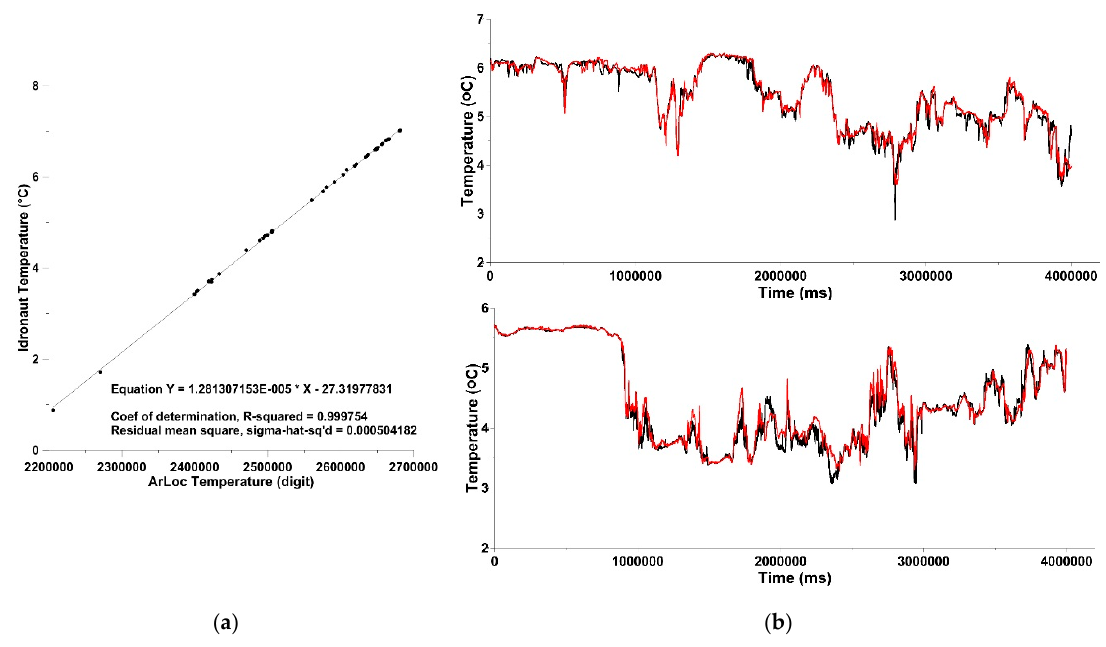
Figure 7. ( a ) Comparison between Idronaut 305 plus and ArLoC temperature sensors; ( b ) temperature trend acquired during two representative transects along Blomstrandbreen glacier, red for ArLoC data and black for the Idronaut 305 Plus data.